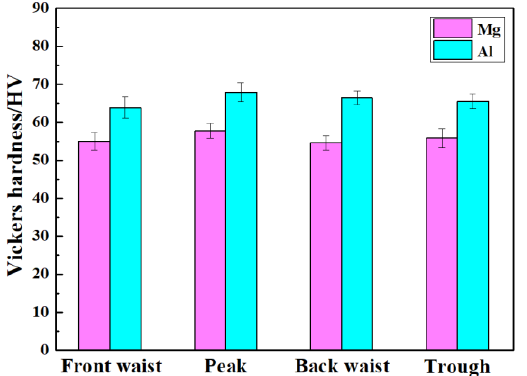
Figure 9. Vickers hardness at interface metals of the corrugated clad sheet.